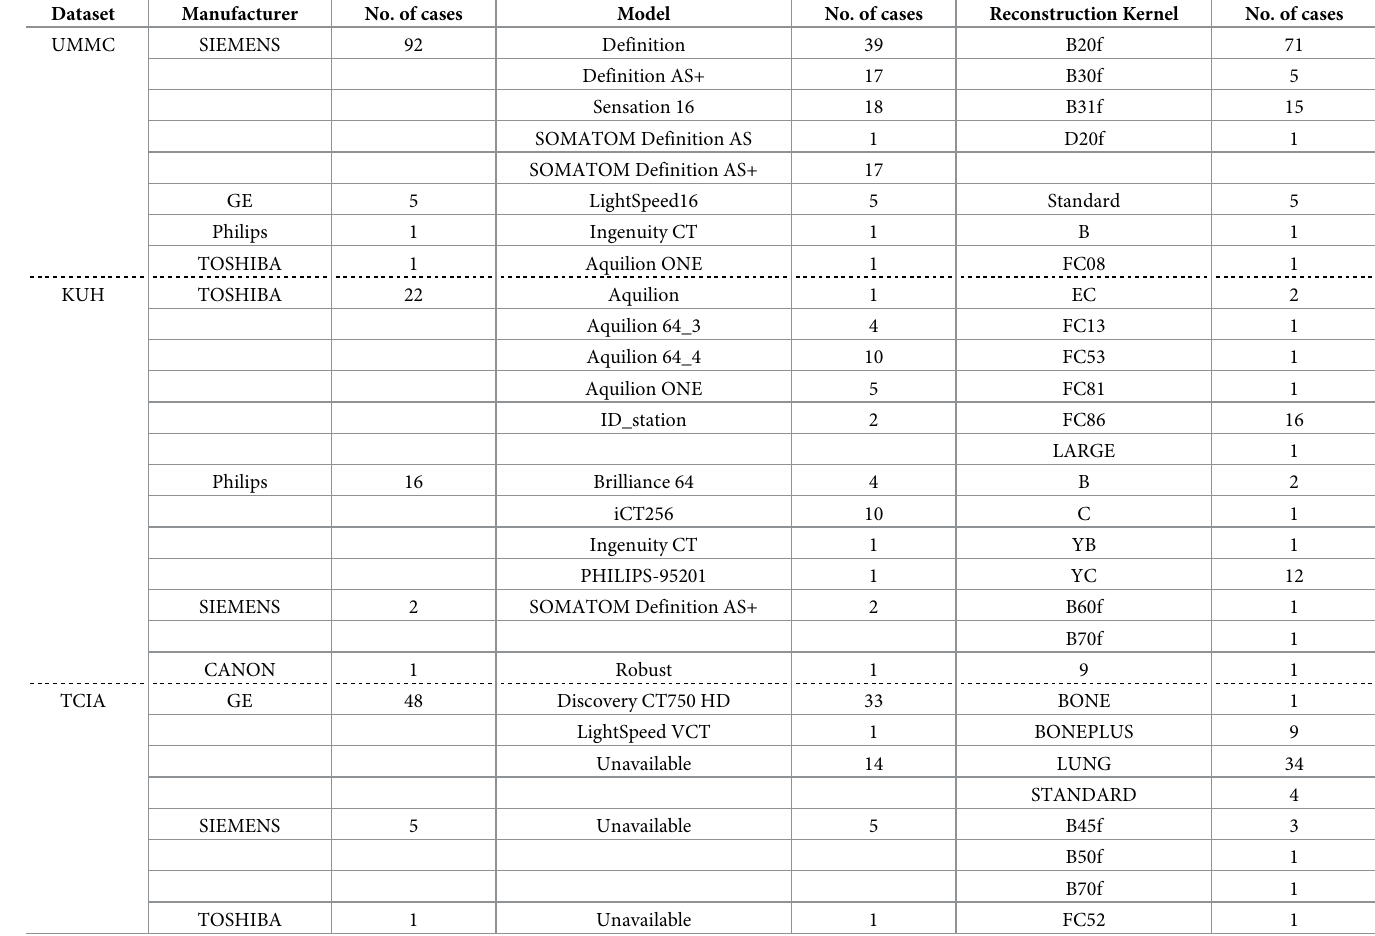
Table 2. Image acquisition parameters in datasets obtained from University of Malaya Medical Centre (UMMC), Kyushu University Hospital (KUH) and The Can- cer Imaging Archive (TCIA). Dataset